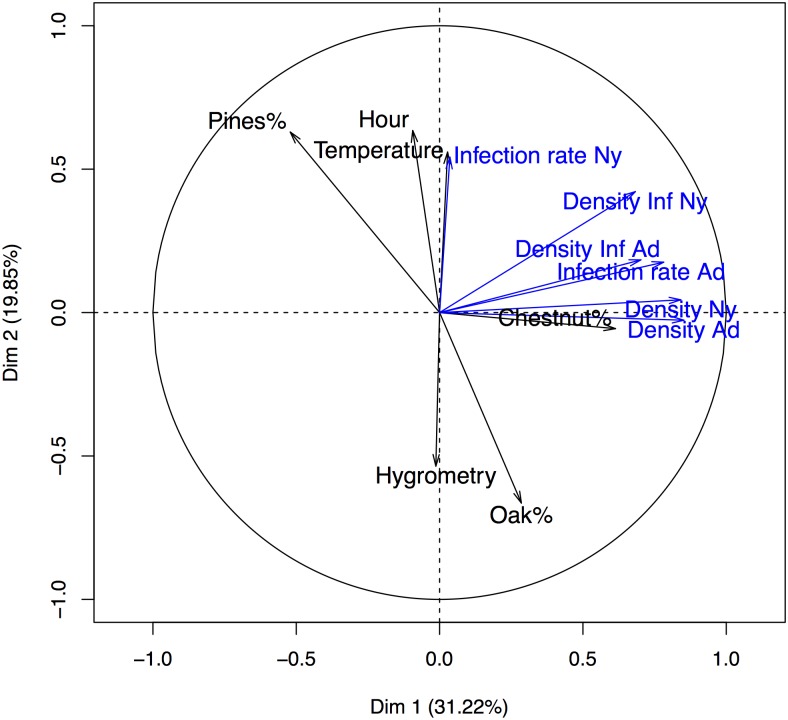
Graph of variables computed by PCA.The tick variables (density, infection rate, density of infected ticks) are presented in blue while in black tree species and climatic data are represented.